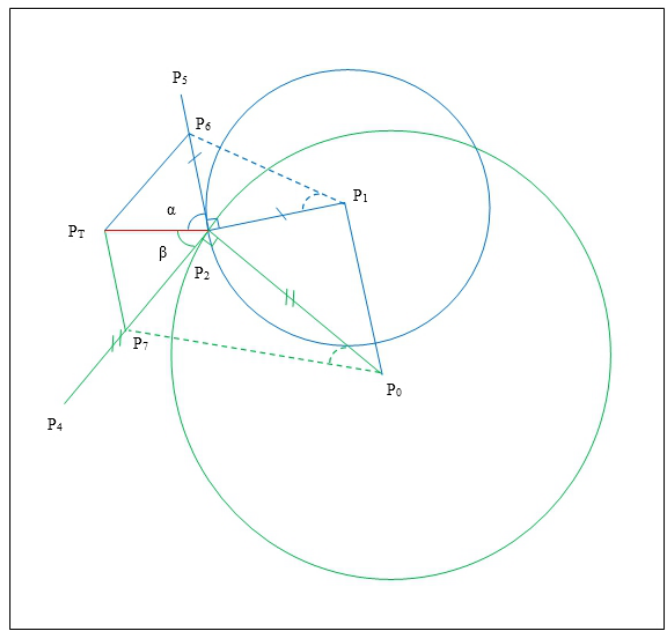
Figure 2. Guide lines and circles for calculating distances in the 2D space overlaid on the live video